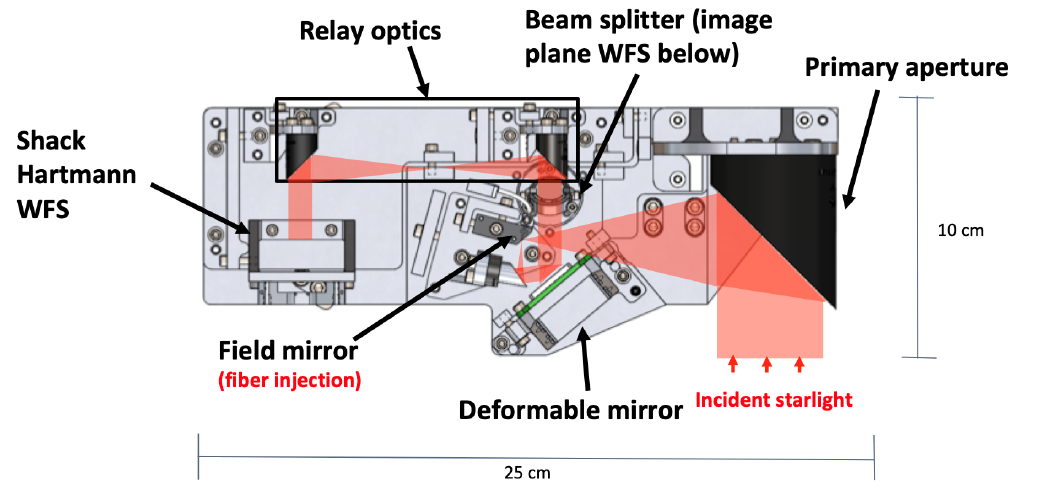
Figure 3. Diagram of the optical components for the Deformable Mirror Demonstration Mission (DeMi) CubeSat payload with ray path